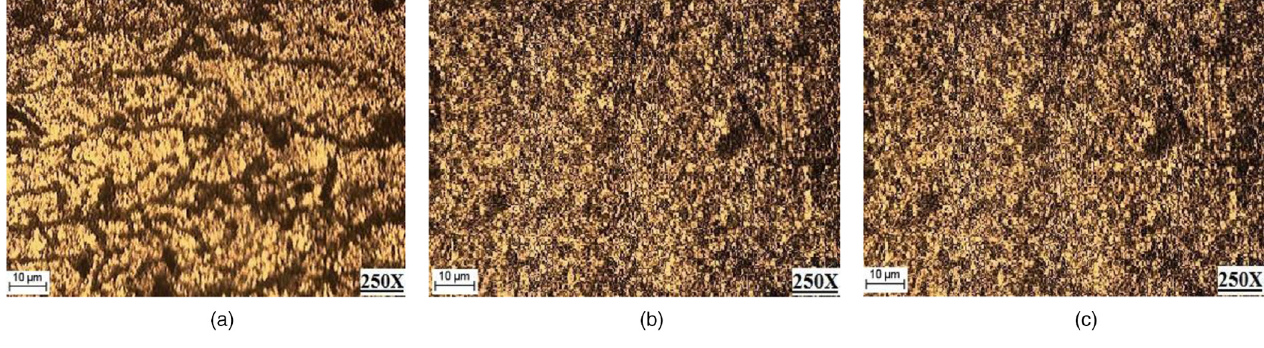
Fig. 6. Grain structure of 8 mm Tin castings for interior, middle as well as external surfaces for speeds of 1250 rpm. (a) 1250 rpm interior surface. (b) 1250 rpm middle surface. (c) 1250rpm external